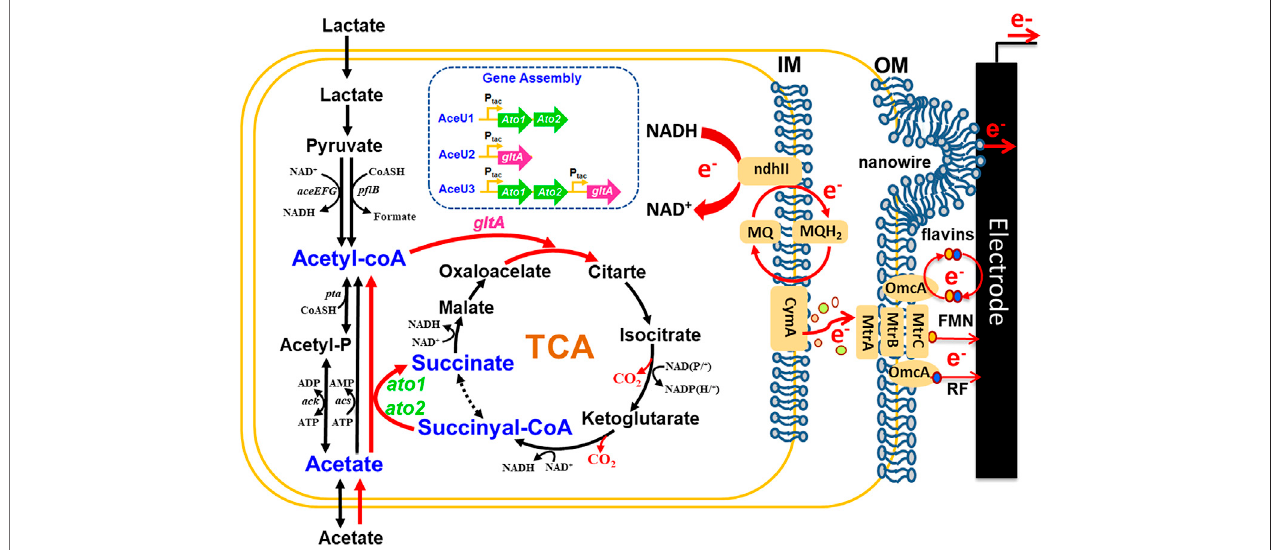
FIGURE1| Construction ofengineered S. oneidensis strainstoenableacetate utilization and electricity generationbasedonsyntheticbiology strategies. Aunique acetateutilizationwayconstructingby ato1 and ato2 (thegenesencodingsuccinyl:acetatecoenzymeAtransferasefrom G.sulfurreducens and gltA (thegeneencoding citrate synthase) from S. oneidensis , which is free of energy-consuming and restores vitality of TCA in anaerobic conditions.